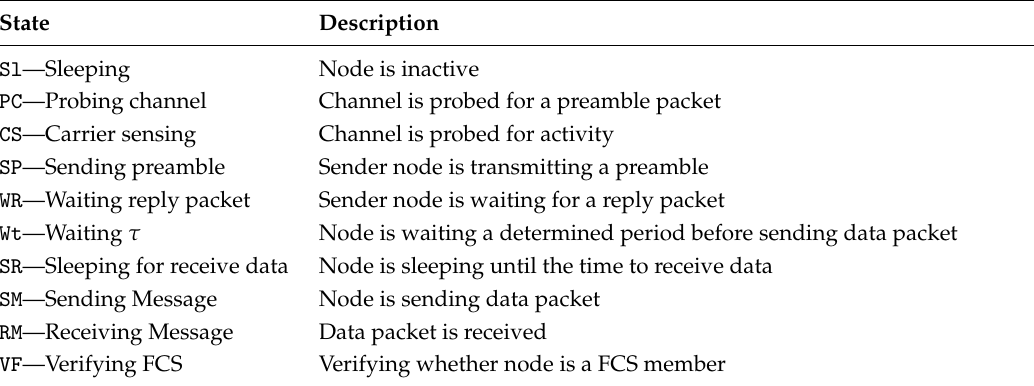
Table 1. List of all MAC states present in the state machine.